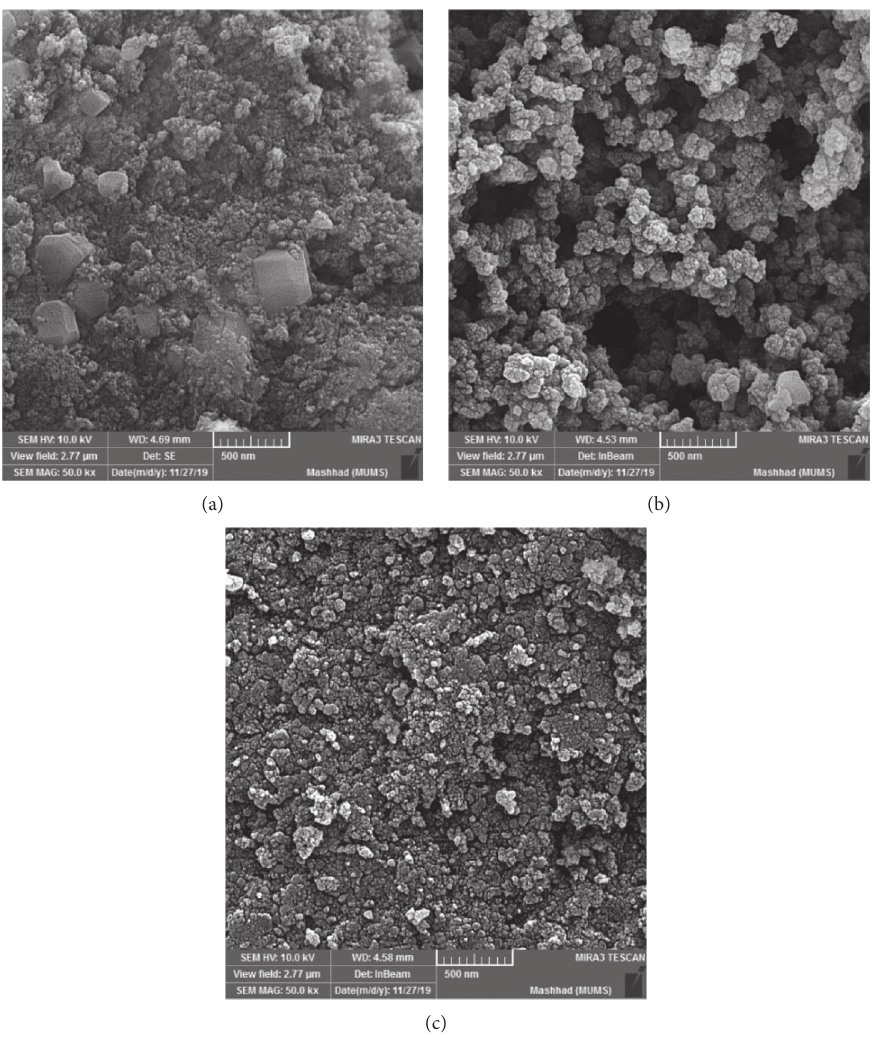
Figure 2: The SEM image of (a) GO-Fe 3 O 4 @SiO2, (b) MIP/GO-Fe 3 O 4 @SiO 2 , (c) and NIP/GO-Fe 3 O 4 @SiO 2